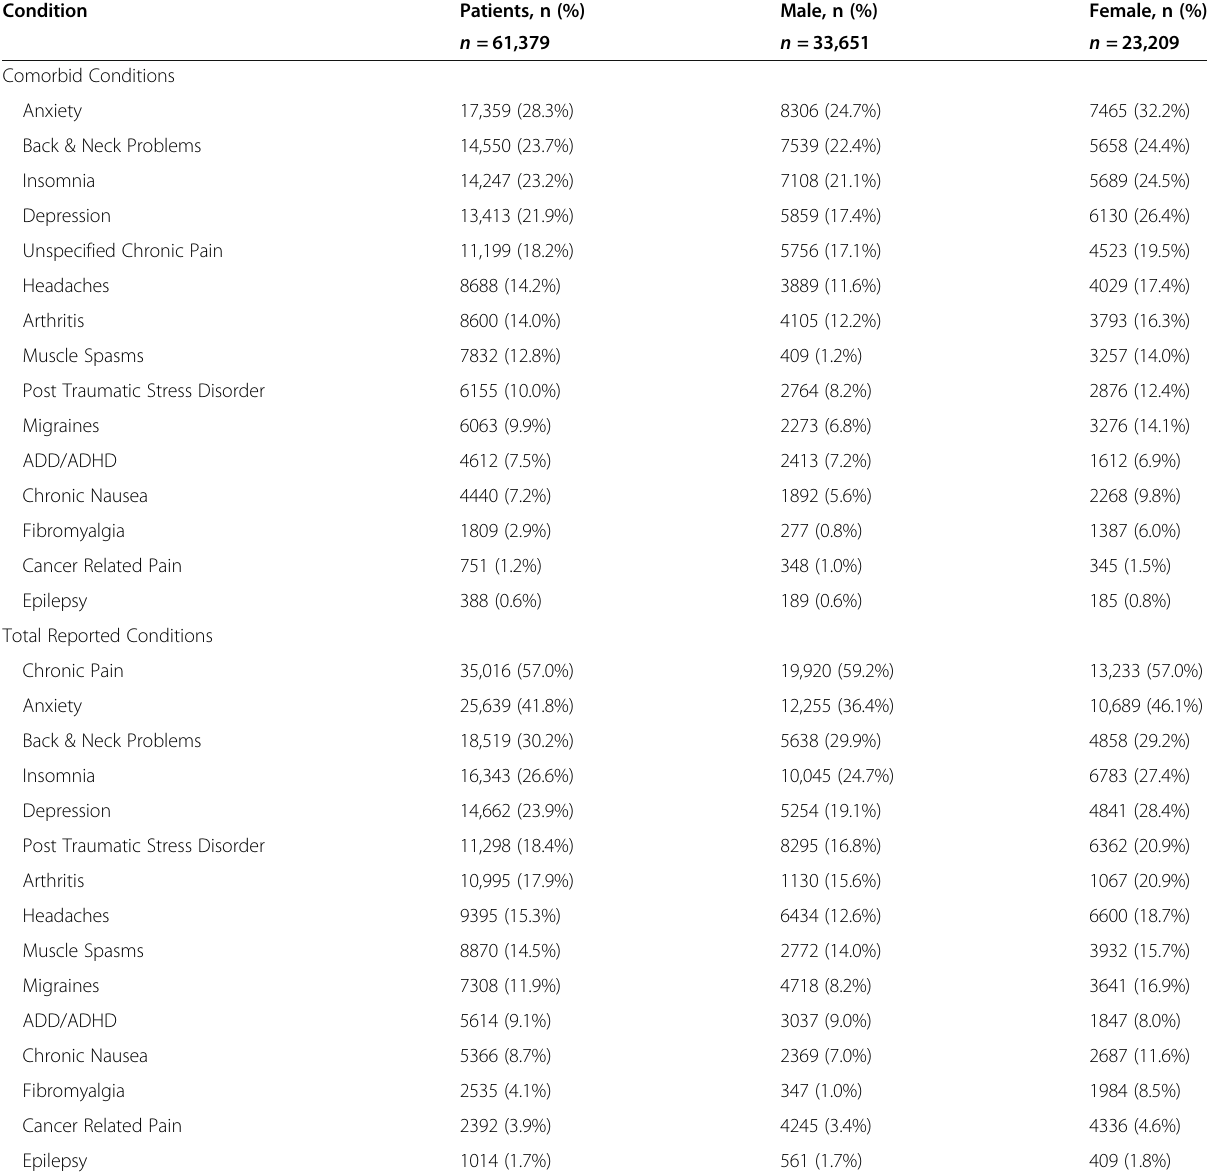
Table 7 Summary of comorbid conditions and all conditions reported by 61,379 patients seeking medical cannabis certification, by